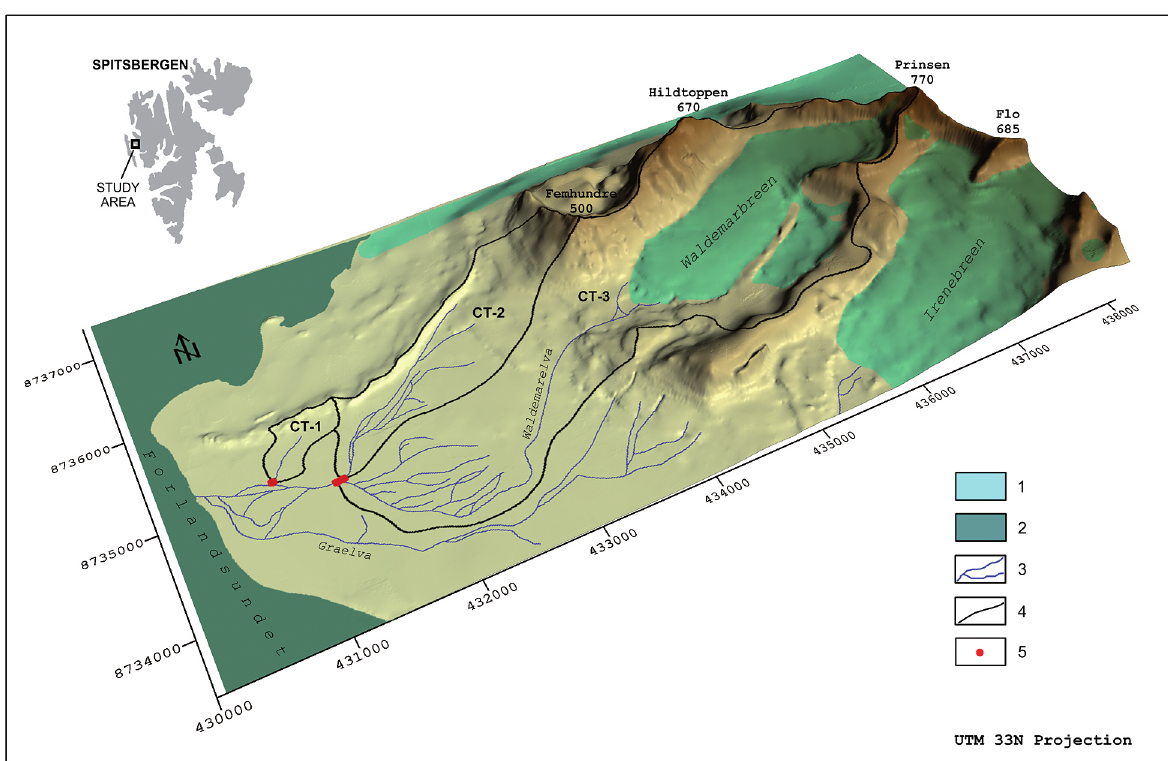
Fig. 1. Investigated river catchments (CT-1, CT-2, CT-3) in the area of Kaffiøyra plain (Oscar II land, NW Spitsbergen) 1 – glaciers, 2 – sea, 3 – rivers, 4 – catchment borders, 5 – gauging stations Block diagram based on a topographic map 1:25,000, prepared by lankauf (2002)